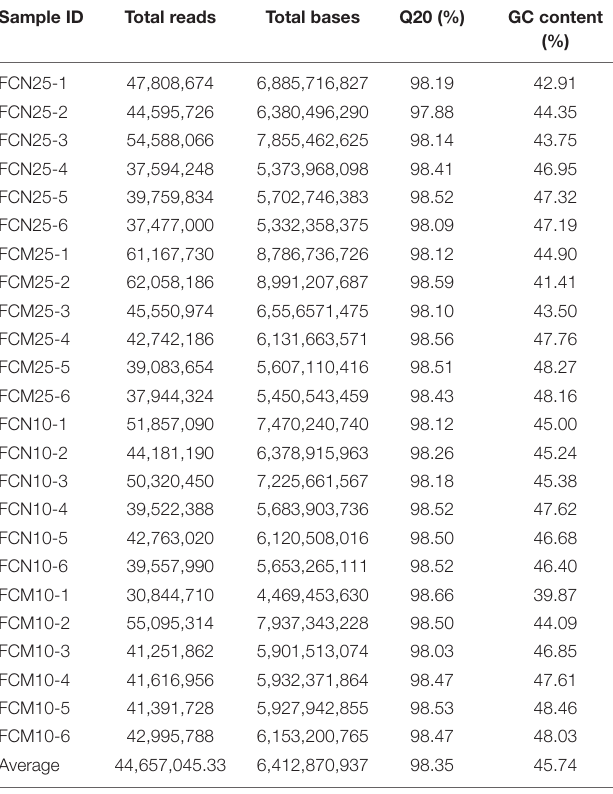
TABLE 2 | Statistics of clean reads.